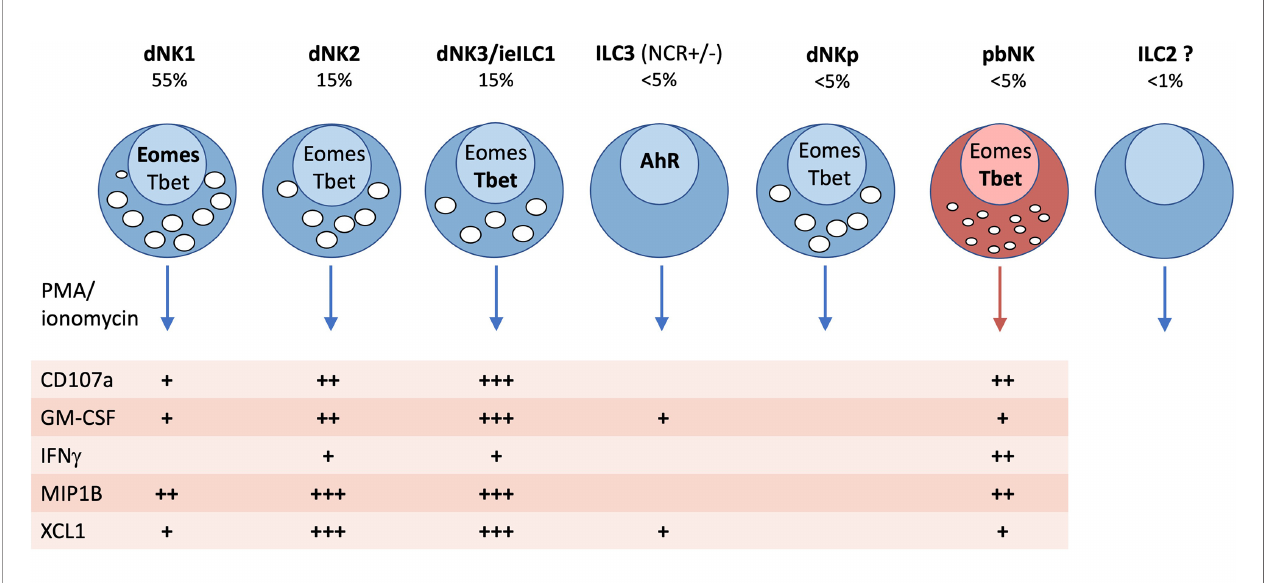
FIGURE 9 | Characteristics of innate lymphoid cells identi fi ed in the human uterus by scRNAseq and mass cytometry. Typical frequencies of each ILC type are given as a percentage of total decidual CD45+HLADR − CD14 − CD19 − CD3 − (Lin − ) gate in freshly isolated cells (not cryopreserved). Frequencies in endometrium will be different. Transcription factor (TF) expression and cytokine responses following PMA/ionomycin stimulation are based on mass cytometry data of Huhn et al. (39). TFs and cytokines listed in bold, indicate stronger staining. For functional responses, blank = 0-10%, + = 10-25%, ++ = 25-50%, +++ = 50+% staining by mass